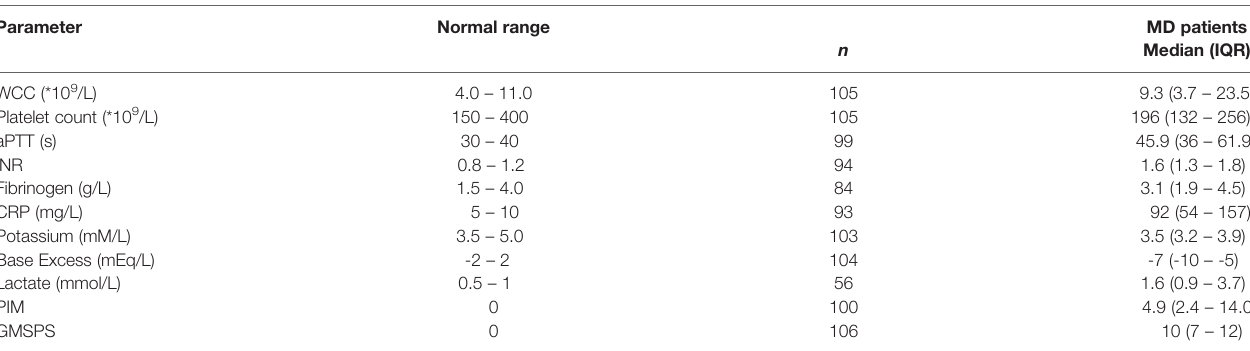
TABLE 3 | Clinical and laboratory